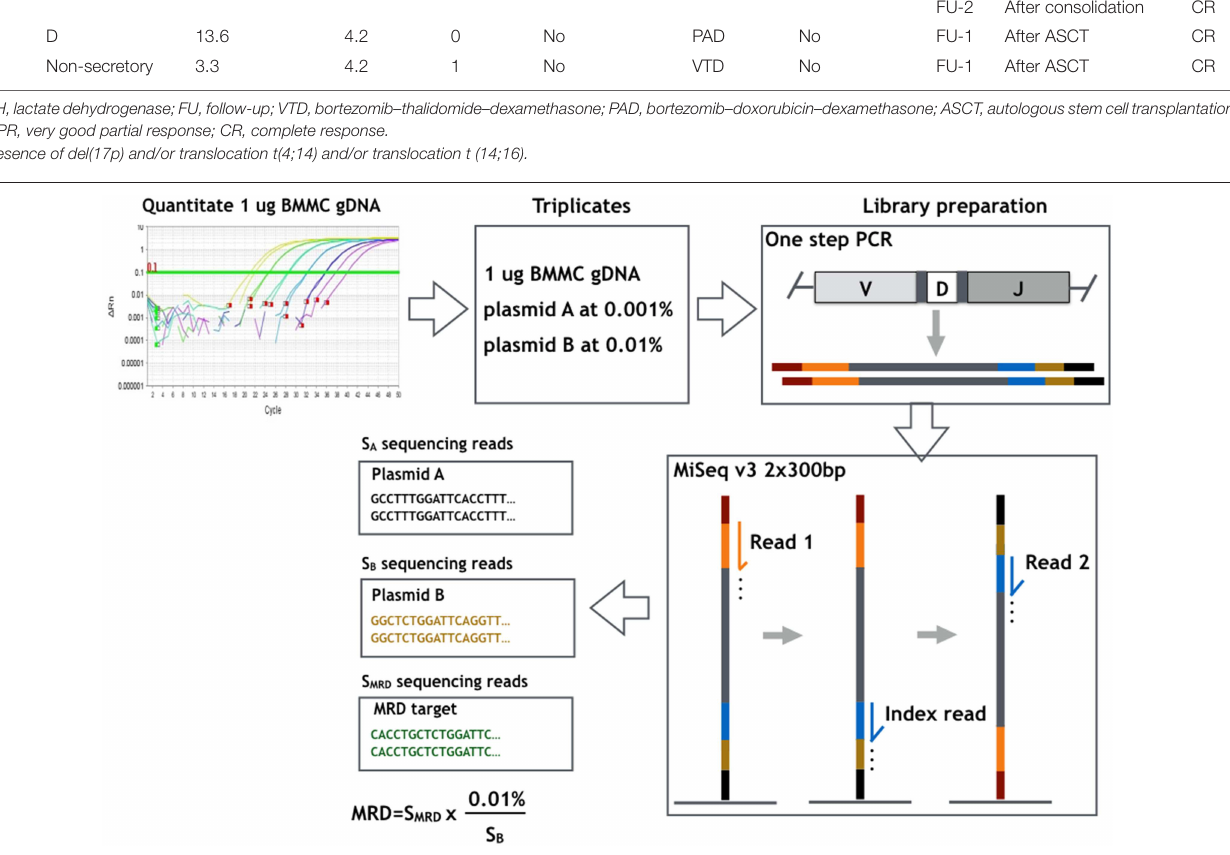
FIGURE 1 | Overview of the workflow of MRD measurement method used and evaluated in the present study. The number of cells contained in 1 µ g bone marrow mononuclear cells (BMMCs) of each sample was determined by real-time PCR standard curve method. Each MRD sample was studied in triplicates of 1 µ g